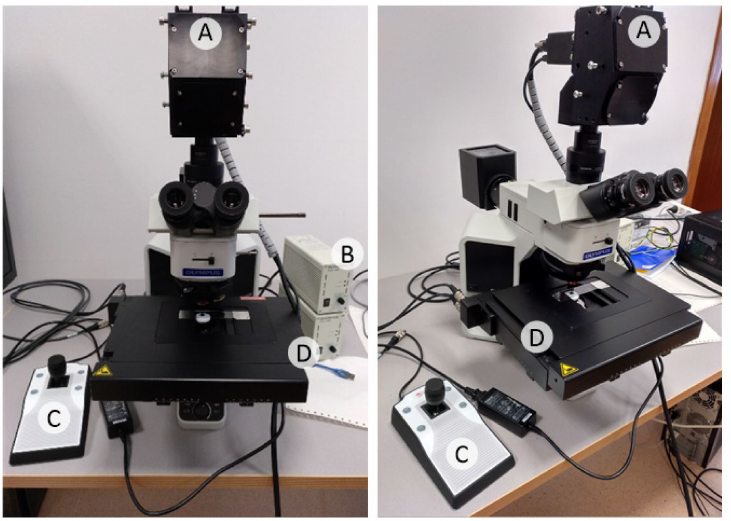
Figure 1. Microscopic HS acq. system. (A) HS camera. (B) Light source. (C) Positioning joystick. (D) Motorized